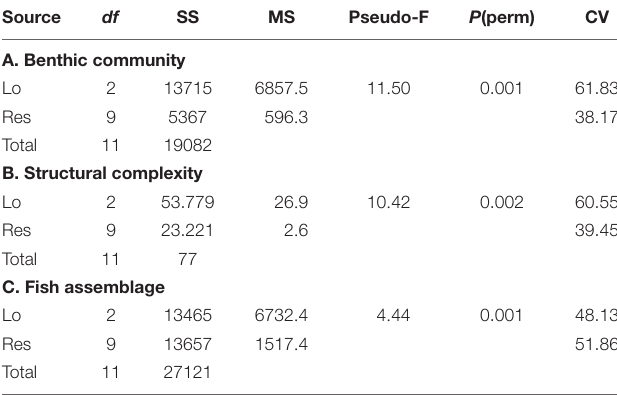
TABLE 1 | Results of PERMANOVAs examining differences among benthic communities, proxies of structural complexity and fish